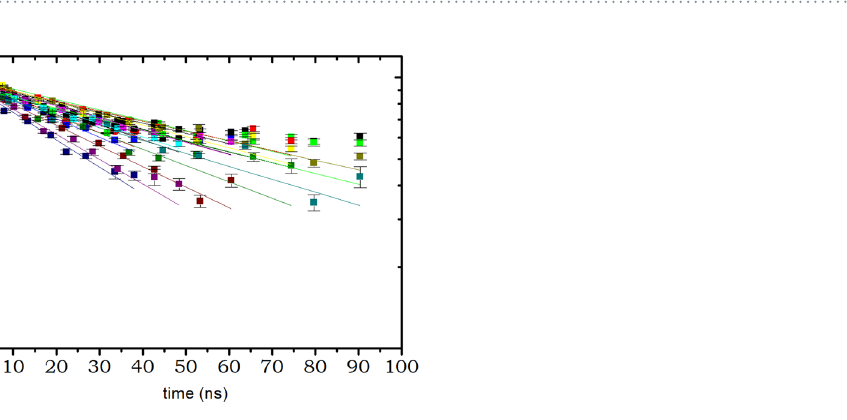
Figure 1. Intermediate scattering function measured on the SNS neutron spin echo spectrometer, at wavevector ranging from q = 0.069 Å − 1 to q = 0.125 Å − 1 , on hemoglobin solution of c p = 105 g . L − 1 . 22 spectra are shown from the 60 that has been measured on 4 different scattering angles.